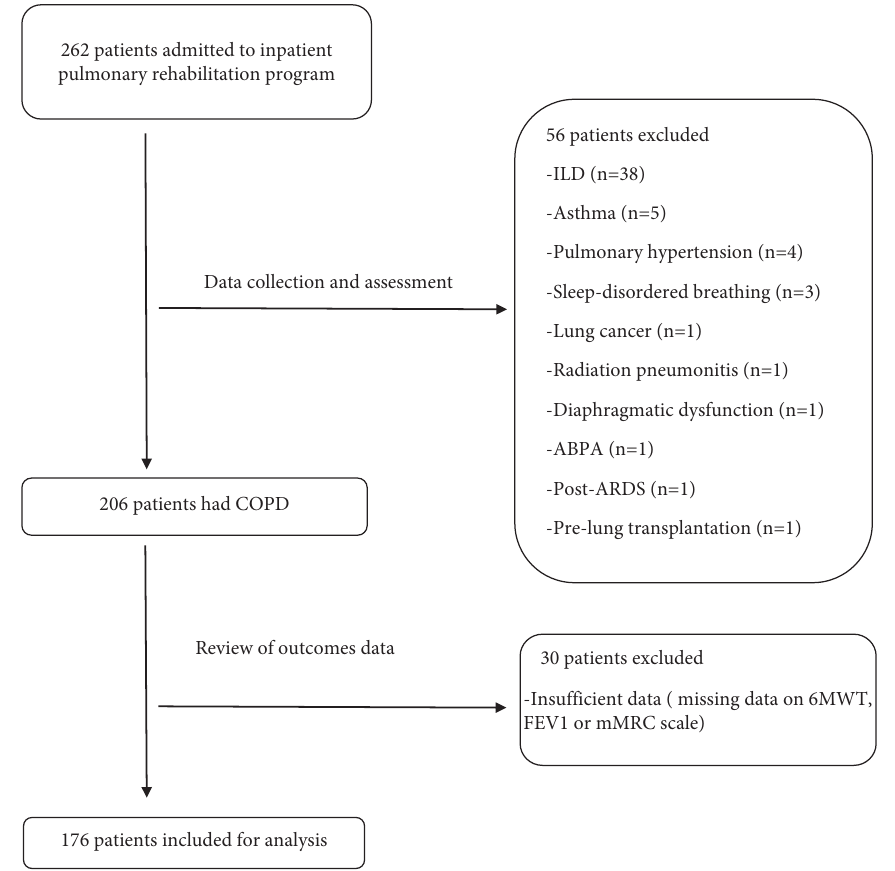
Figure 1: Flowchart of patients’ enrollment